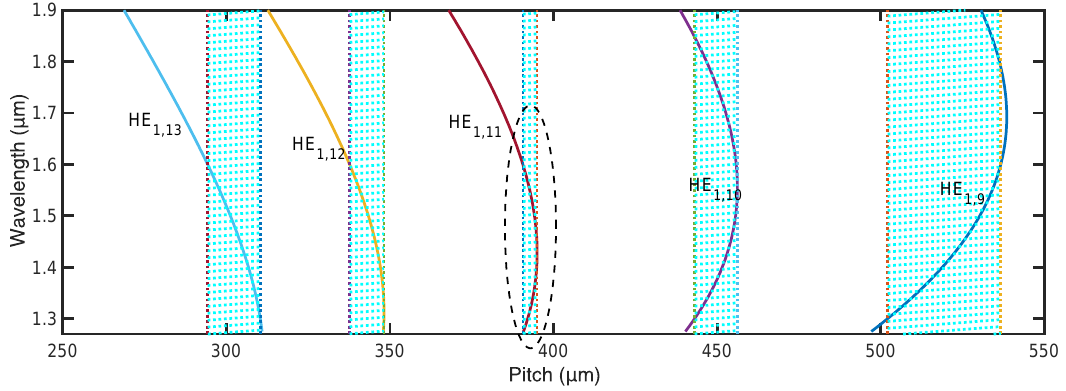
Figure 7. Phase-matching curves of coated chirped CLPG for operating wavelength range from 1.30 to 1.62 μ m.